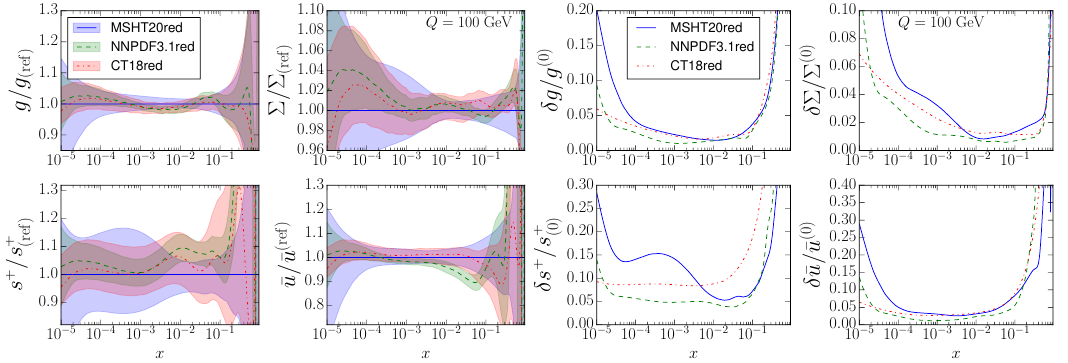
Figure 2: Comparison of the reduced fits of all 3 groups (CT, NNPDF, MSHT), ratio of central values (left) and uncertainties (right), with the baseline for the ratio taken as the MSHT20 reduced